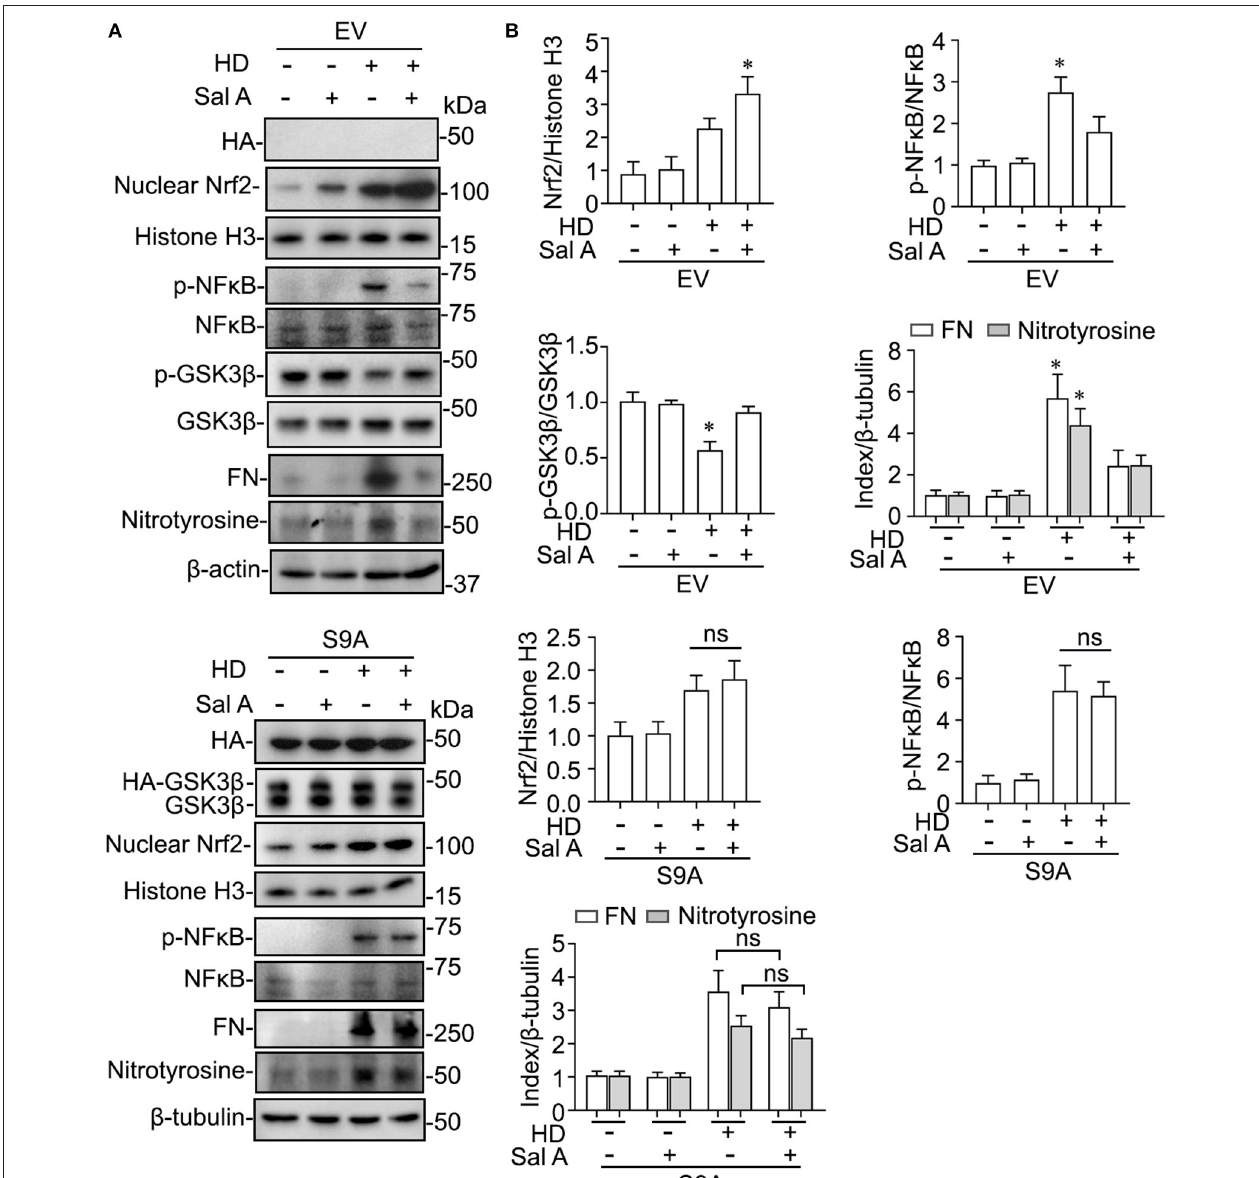
FIGURE 6 | GSK3 β inhibition is required for the regulatory effect of Sal A on NFkB and Nrf2 activation in cultured peritoneal mesothelial cells exposed to hypertonic dextrose. (A) Primary cultures of murine peritoneal mesothelial cells were transfected with the empty vector (EV) or the vector encoding the HA-conjugated constitutively active mutant of GSK3 β (S9A) and then were exposed to hypertonic dextrose (HD) or vehicle treatment for 48h. Representative immunoblots showing immunoblot analysis of collected cells for indicated molecules. (B) Relative abundance of indicated proteins, as normalized to the expression of histone H3, NF κ B, total GSK3 β , β -actin or β -tubulin based on densitometric analyses of immunoblots ( n = 3). Data were analyzed by one-way ANOVA followed by Tukey’s test. * P < 0.05 vs. other groups. ns, not